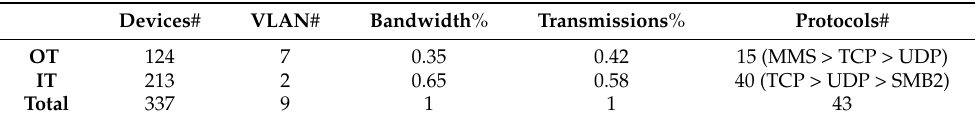
Table 1. Summary of the collected traffic.